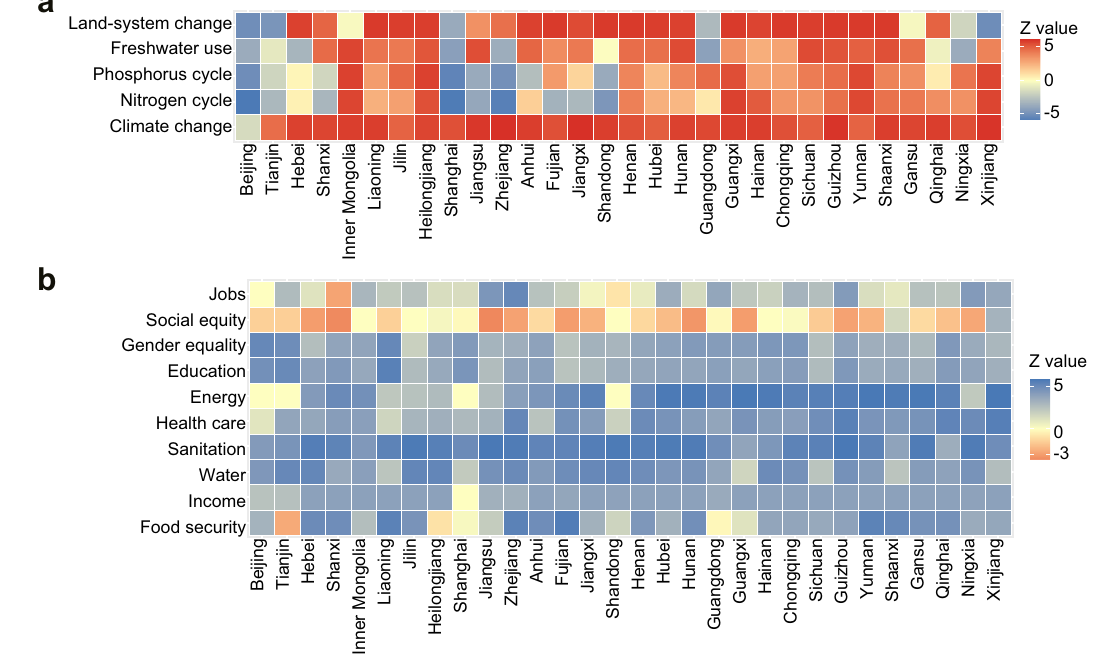
Fig. 5 | Changing trends of sustainability performance in China ’ s provinces from 2000 to 2018. a Environmental performance. b Human well-being. Envir- onmental performance indicates environmental footprints to downscaled plane- tary boundaries. Human well-being represents social indicators to social thresholds. Z-score values indicate the results of Mann-Kendall test, with red color